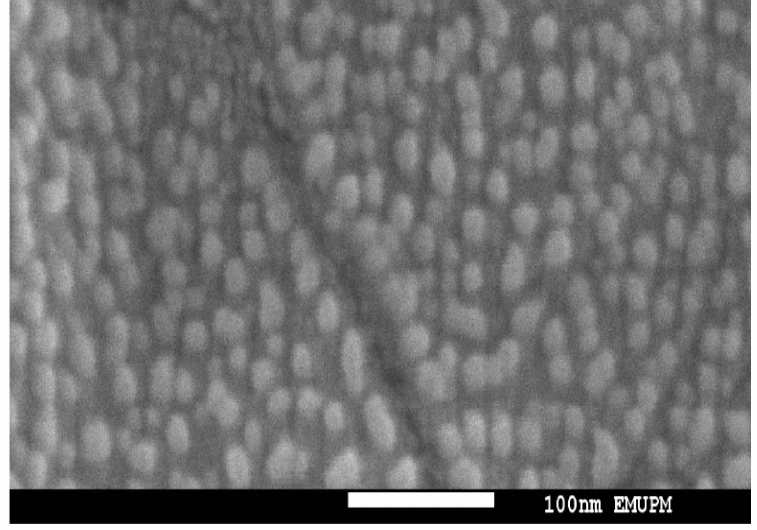
Figure 1. Scanning electron microscopy image of C- Φ